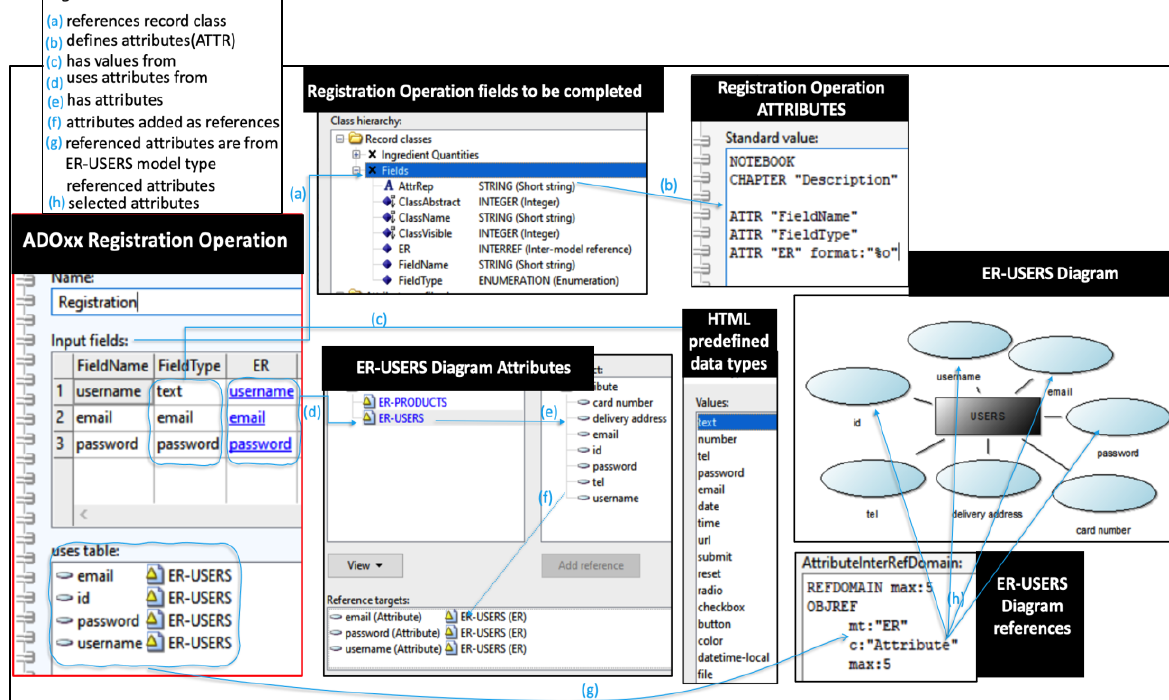
Figure 4. Exemplification of an Input Operation and its mapping on ER elements